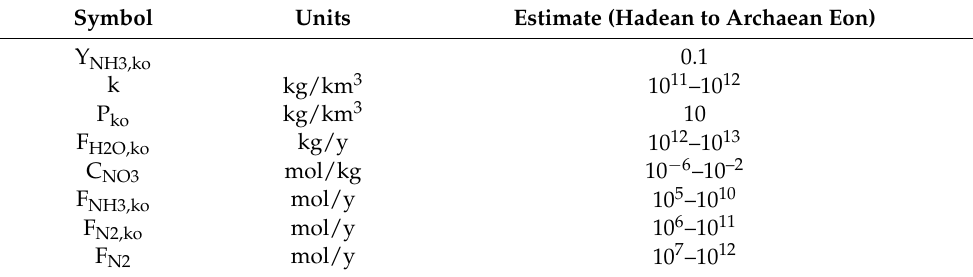
Table 8. Estimates of ammonia and dinitrogen production rates by thermochemical nitrate reduction in the early oceans. Symbol Units Estimate (Hadean to Archaean Eon) Y NH3,ko 0.1 k kg/km 3 10 11 –10 12 P ko kg/km 3 10 F H2O,ko kg/y 10 12 –10 13 C NO3 mol/kg 10 − 6 –10 –2 F NH3,ko mol/y 10 5 –10 10 F N2,ko mol/y 10 6 –10 11 F N2 mol/y 10 7 –10